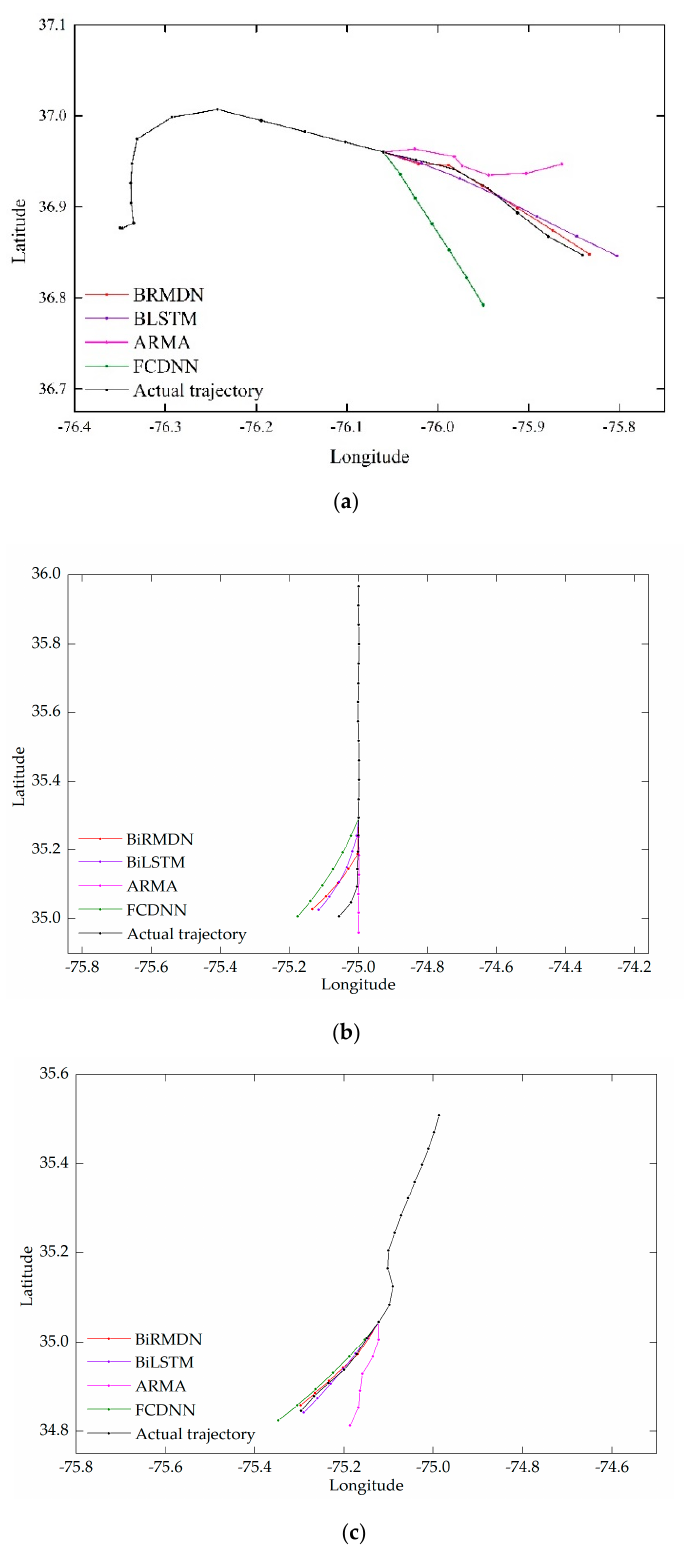
Figure 10. Instances of the prediction results of three different trajectories. ( a ) Curving trajectory. ( b ) Trajectory with inflection. ( c ) Uniform trajectory.